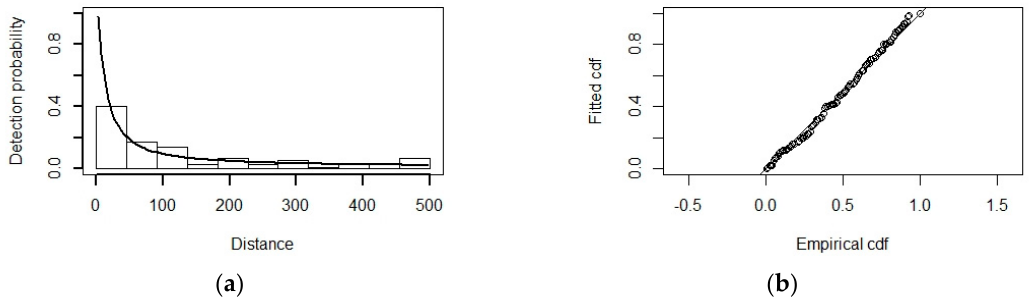
Figure 3. Plot of the fitted detection function ( a ) and goodness-of-fit plot ( b ) for the hazard rate model with sea state and cluster size as covariates.